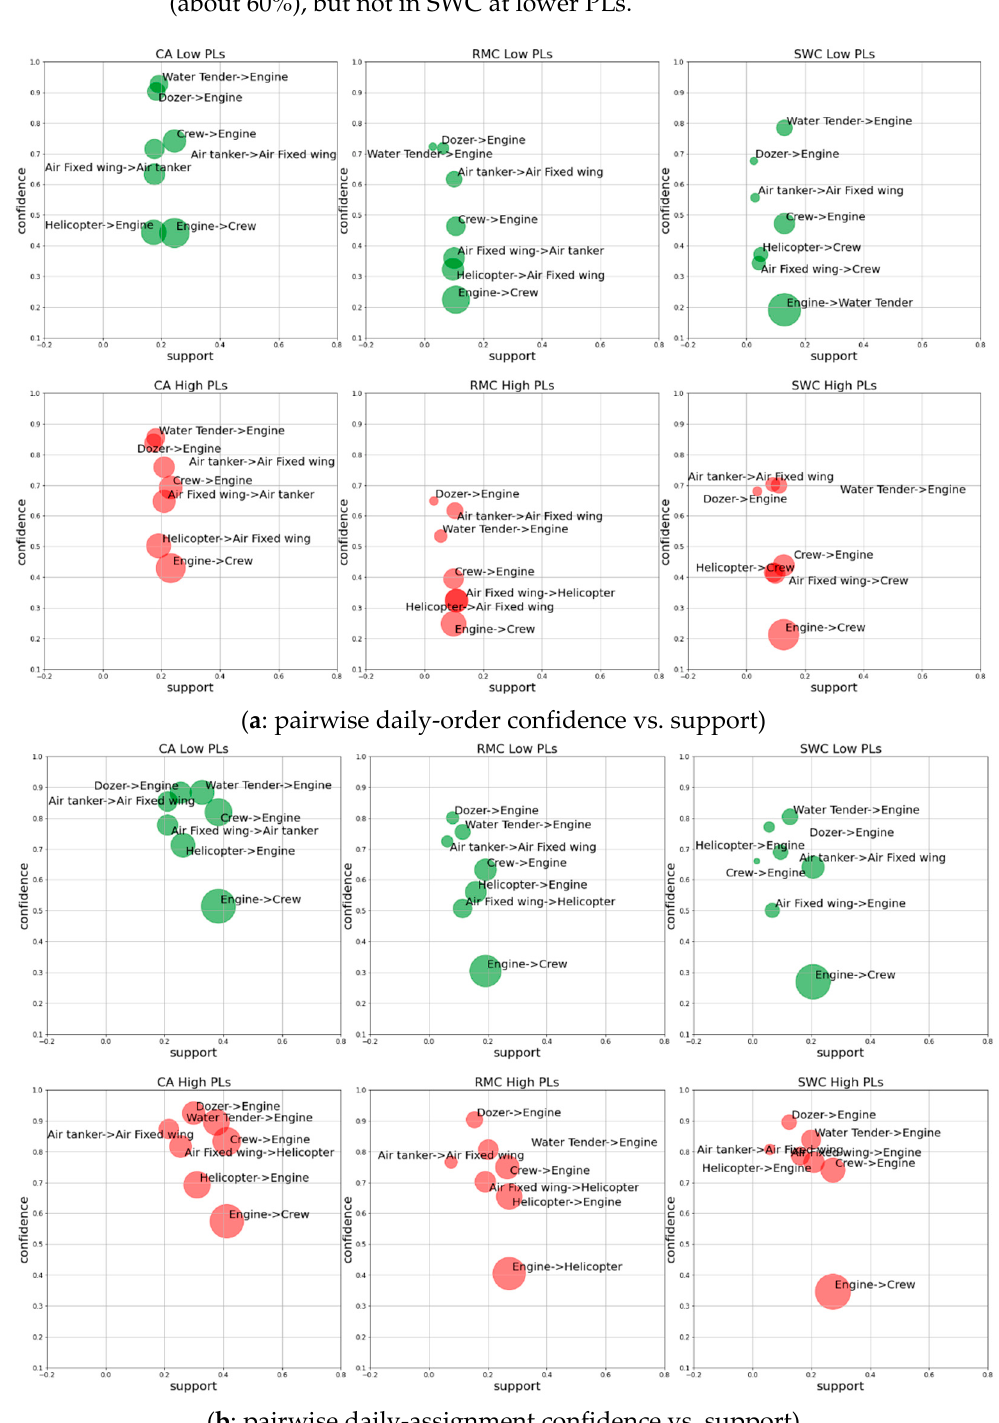
Figure 6. Bubbled scatter plots displaying the confidence and support of selected rules for both resource order and resource assignment. For each resource type as antecedent, only the rule with the highest confidence is graphed. Circle size is proportional to the support of the corresponding antecedent resource.